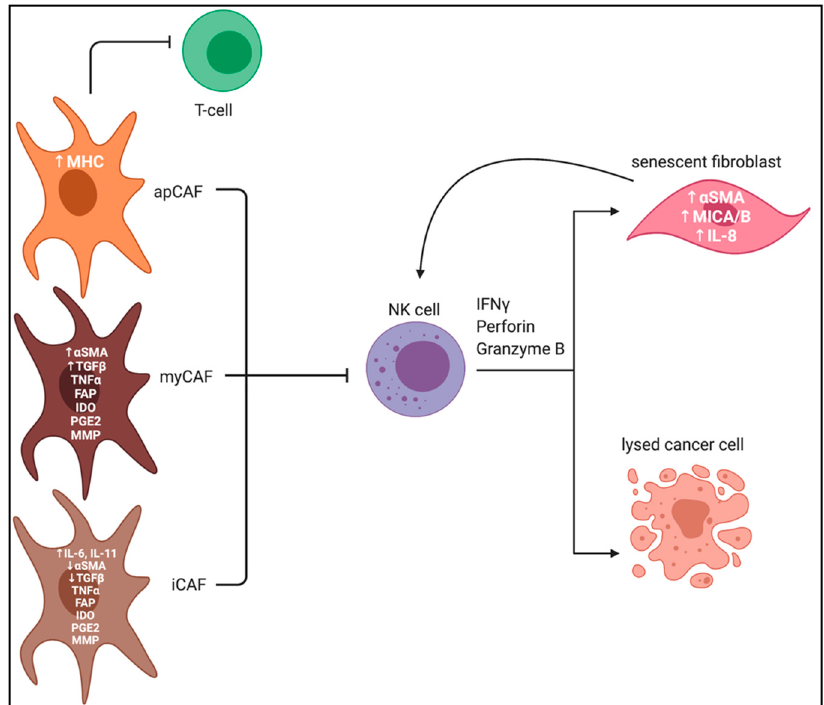
Figure 1 . Cancer-associated fibroblast subpopulations influence NK cell activity. Activated CAFs, including myCAFs, iCAFs, and apCAFs, secrete a variety of cytokines, chemokines and MMPs to inhibit immune cell activity, particularly inhibiting NK cell cytotoxicity against malignant epithelial cells. CAF subpopulations have variable expression of distinct markers, including α SMA, IL-6 and FAP, the latter potentially targetable to overcome CAF-mediated NK cell immunosuppression. Senescent fibroblasts [80] secrete IL-8 to stimulate NK cell activity to allow for NK-cell mediated lysis of fibroblasts [Created with BioRender.com].